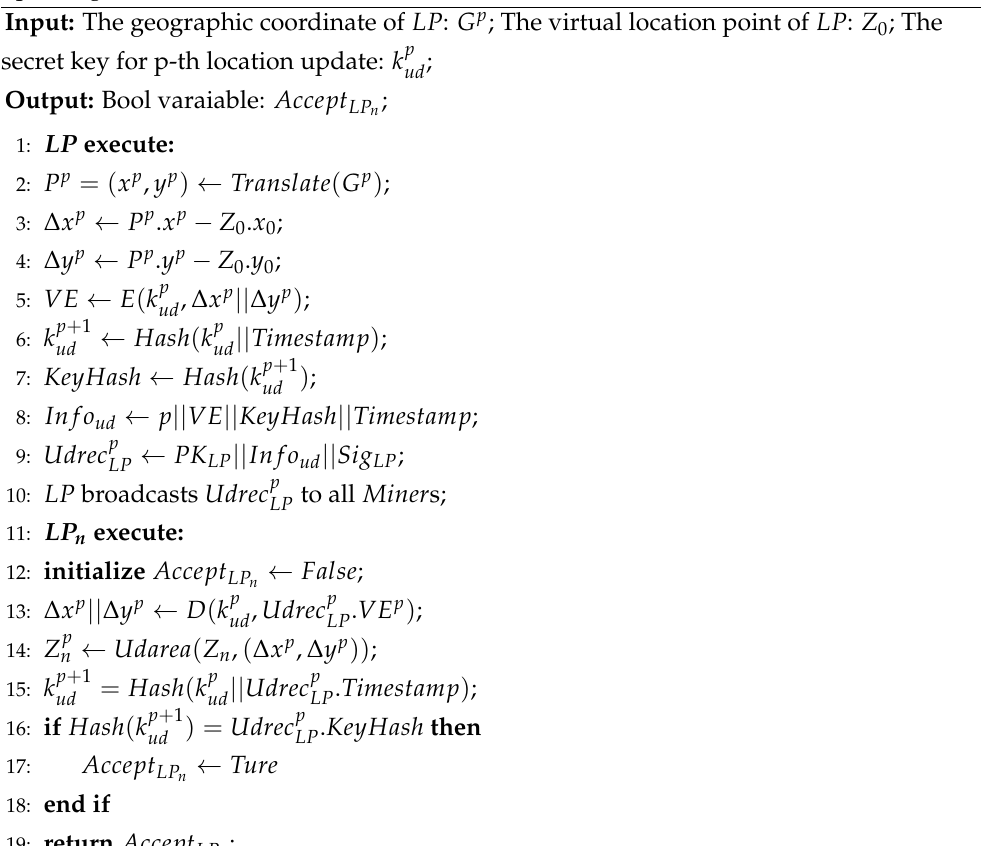
Algorithm 5 Location update: pseudocode for computing location update record